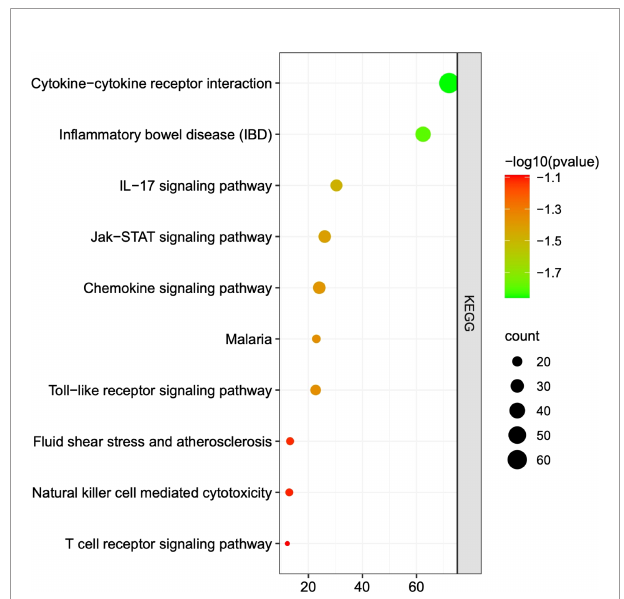
FIGURE 3 | The top 10 pathways of KEGG analysis. Each dot represents a pathway, and the larger the dot is, the more genes it contains. The greener the dot is, the greater the difference. The three most signi fi cantly different pathways in KEGG analysis were “ cytokine - cytokine receptor interaction ” , “ in fl ammatory bowel disease ” , and “ IL-17 signaling pathway ”